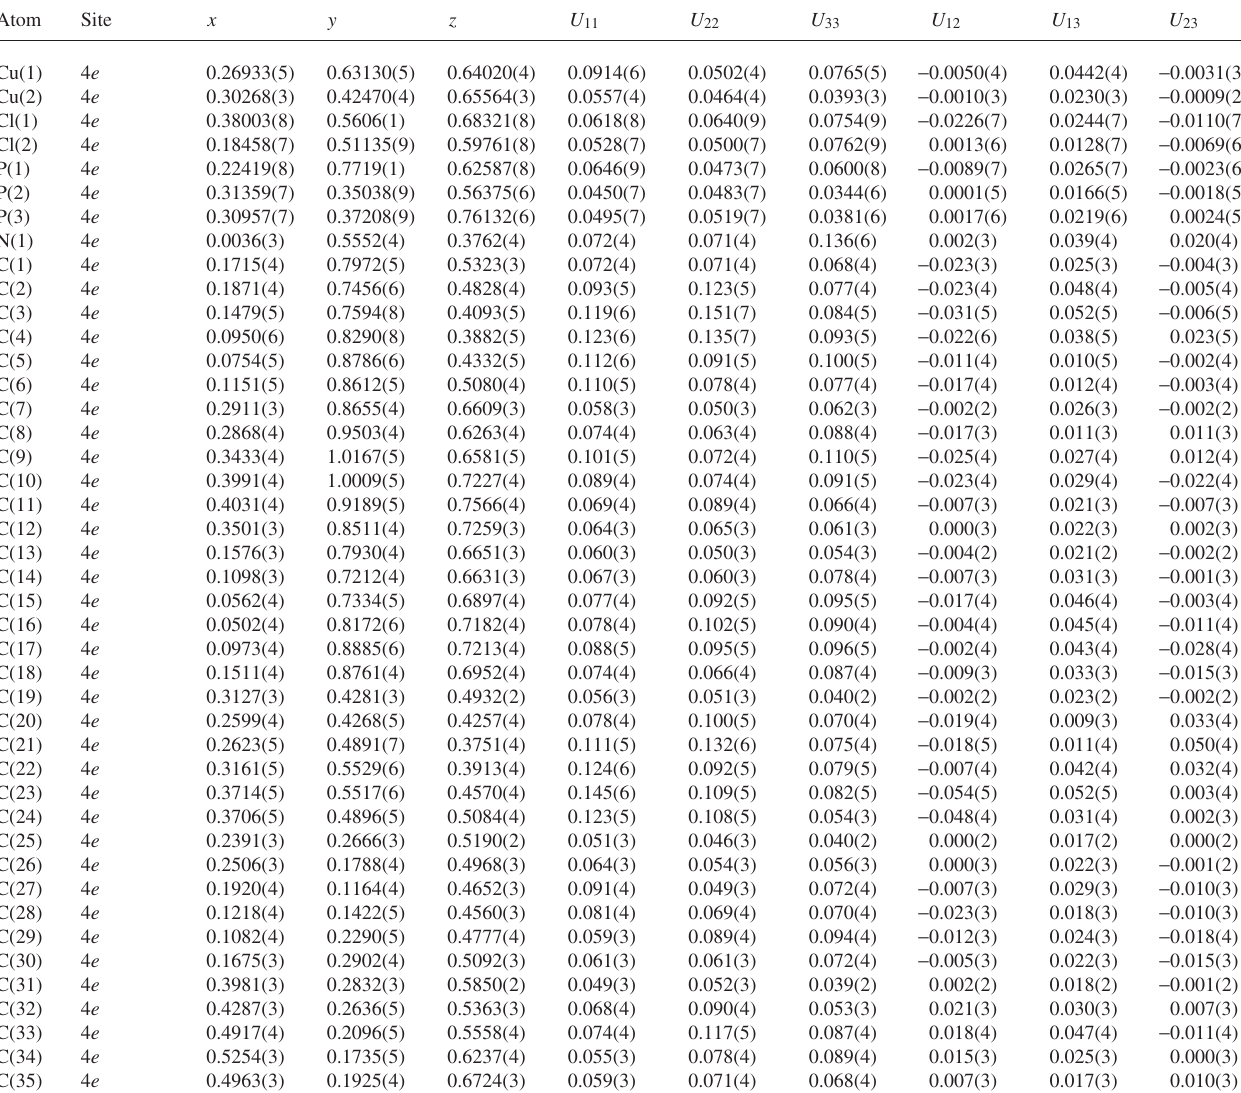
Table 3. Atomic coordinates and displacement parameters (in Å 2 )